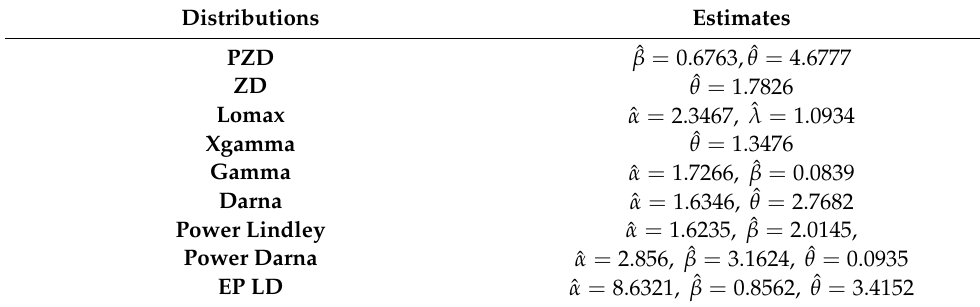
Table 5. ML parameter estimates for the alternative distributions based on failure times data.